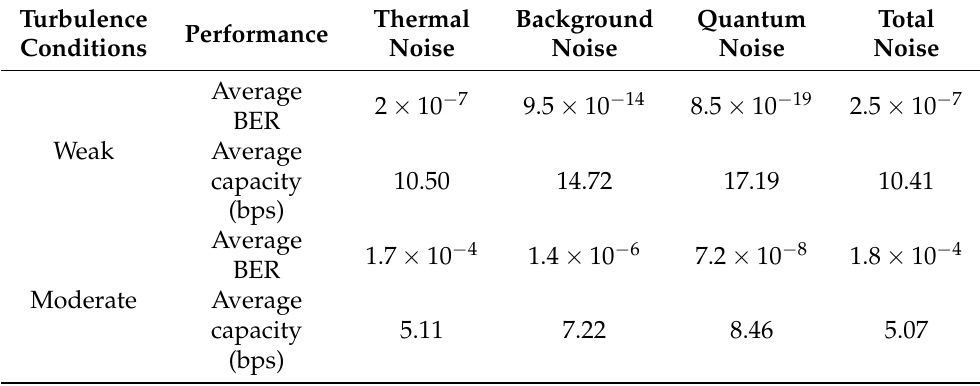
Figure 6. ( a ) Average BER versus average irradiance received under different types of noise; ( b ) average capacity versus average irradiance received under different types of noise ( C 2 n = 0.75 × 10 − 14 m − 2/3 for moderate turbulence, λ = 850 nm, R b = 0.155 Gb/s). Table 2. Average BER and average channel capacity of an FSO communication system under weak and moderate turbulence conditions with various types of noise ( I o = − 20